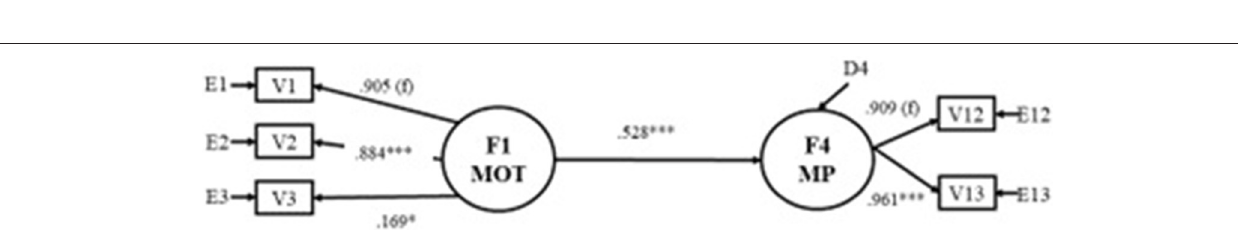
FIGURE 3 | Total effect (in standardized scores) of F1 on F4. F1MOT, Motivation; F4MP, Mathematical Performance; V1, Competence-motivation; V2, Attention-persistence; V3, Positive internality; V12, Informal skills; V13, Formal skills. f , fixed effect; * p < 0.05; *** p <